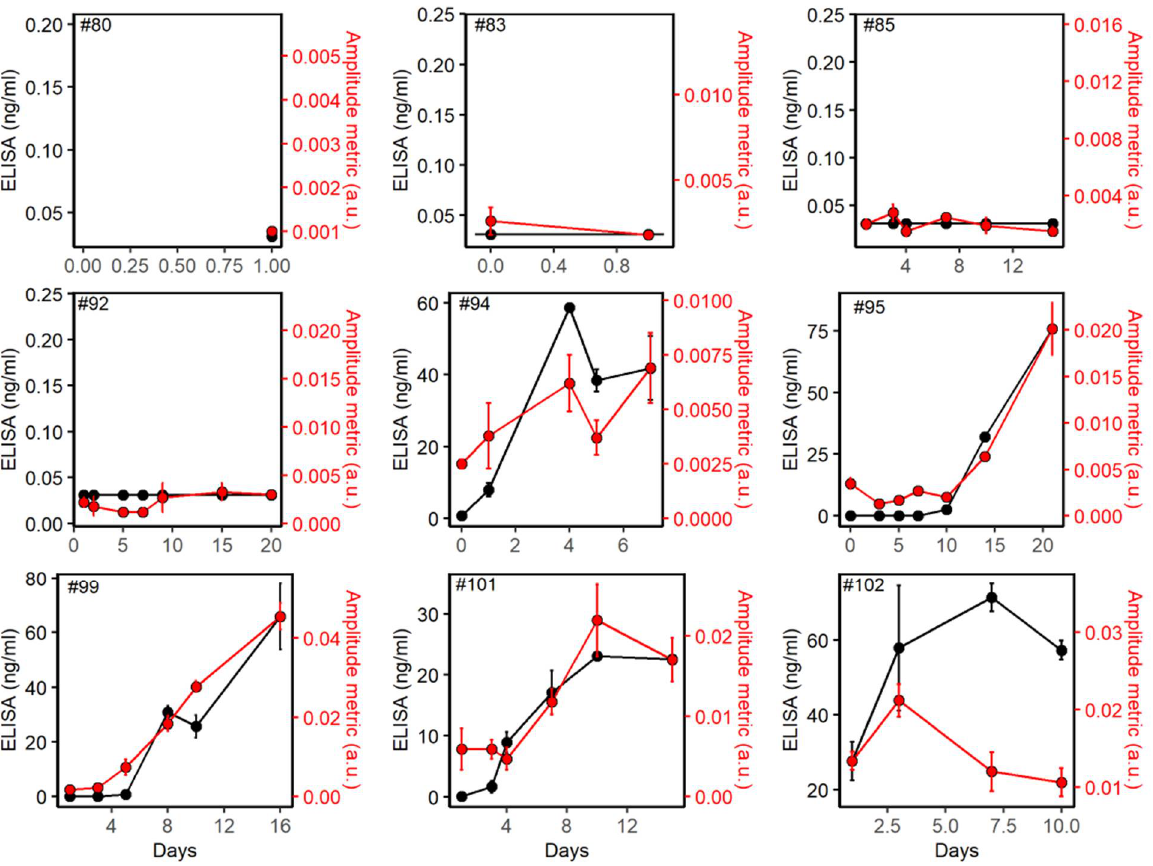
Figure 4. Plots for IgM antibodies. ELISA (y1 axis) and IgM amplitude metrics (y2 axis) with respect to days of ICU for COVID− (IDs #80, 83, 85 and 92) and COVID+ (IDs #94, 95, 99, 101 and 102) participants. Individual data points show mean ± standard deviation of 2 measurements for ELISA and 3 measurements for thermo-photonic methods.